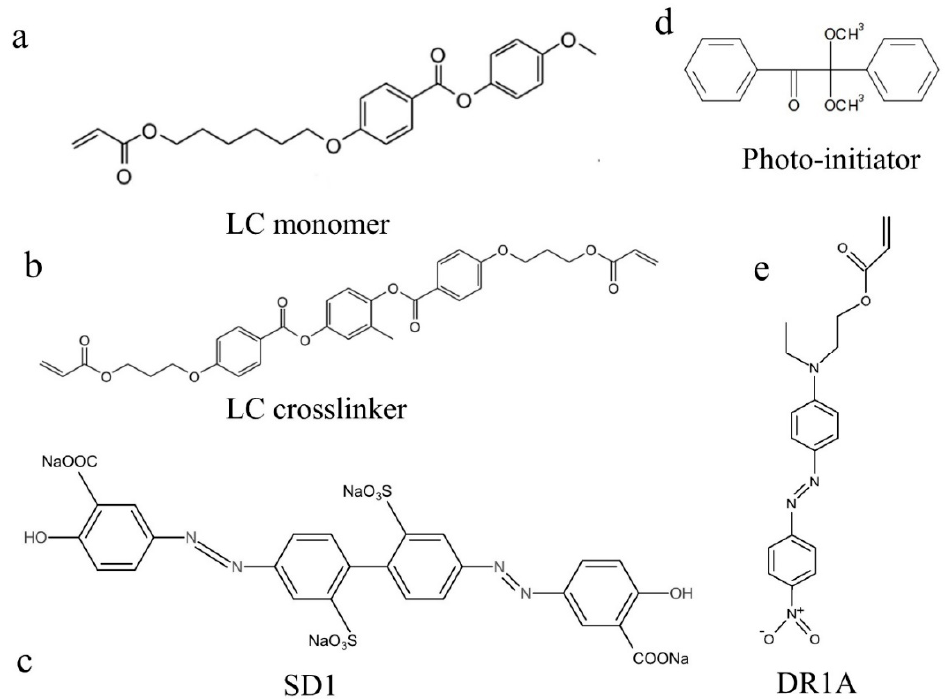
Figure 1. Chemical structures of azo dye and components of LCE. ( a ) LC monomer; ( b )LC crosslinker; ( c ) Azo dye SD1; ( d ) Photo-initiator; ( e ) Disperse Red 1 acrylate (DR1A).